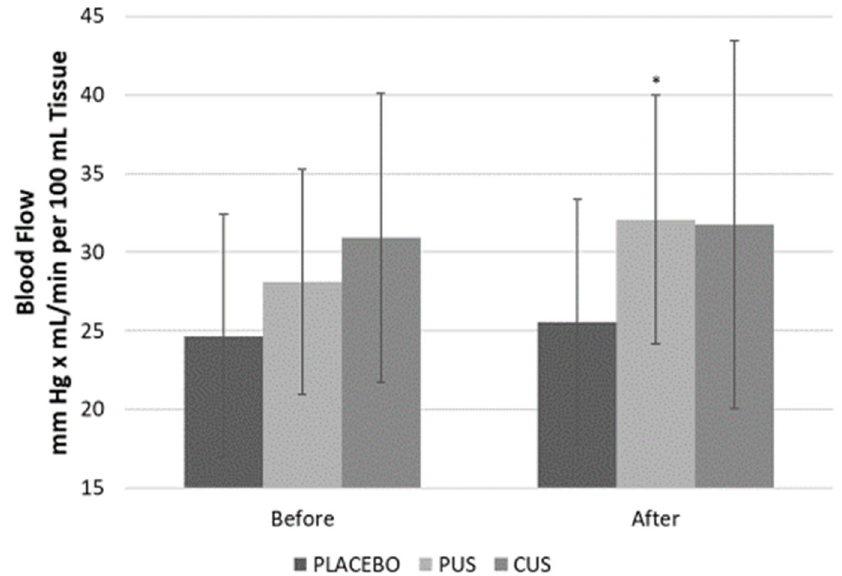
Figure 3. Peak forearm blood flow after reactive hyperemia before and after therapeutic ultrasound application. Data presented as average and S.D. PUS: pulsed ultrasound; CUS: continuous ultrasound; * p < 0.05 before vs. after in PUS.